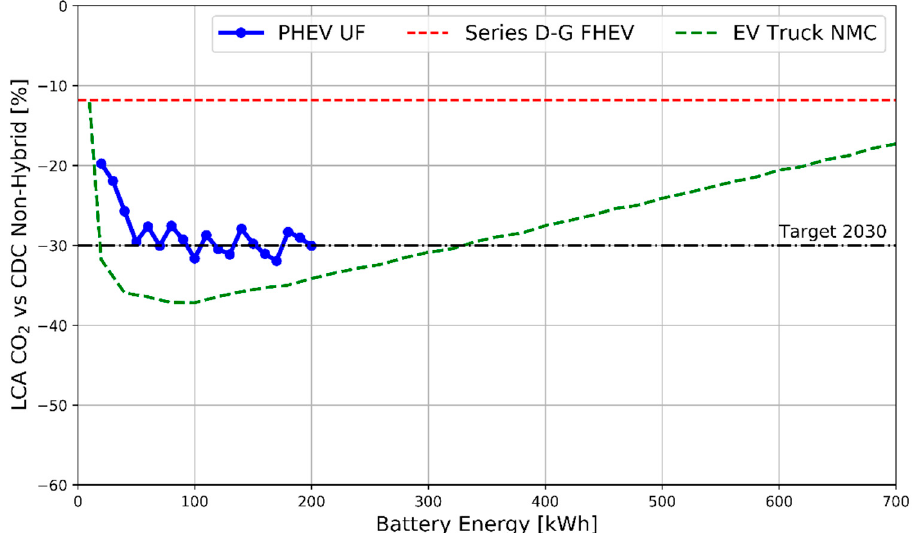
Figure 15. Plug-in hybrid life cycle analysis CO 2 emission differences versus nonhybrid truck, divided into different utility factors under a WHVC with 50% payload. Target 2030, full hybrid, and pure electric are added for comparison.